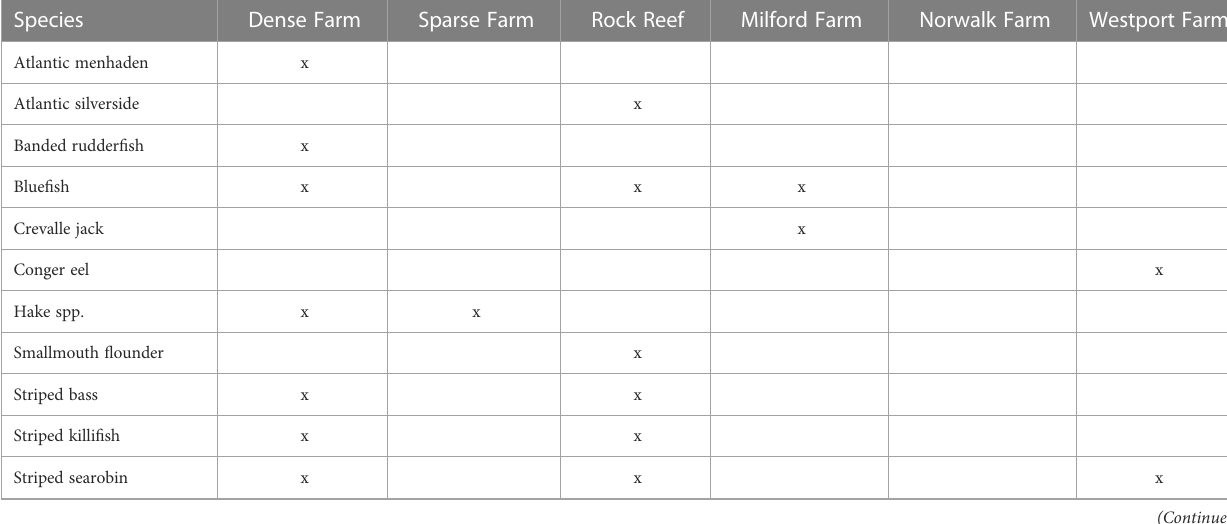
TABLE 2 Occurrence of numerically rare species across habitats and farm locations. Species Dense Farm Sparse Farm Rock Reef Milford Farm Norwalk Farm Westport